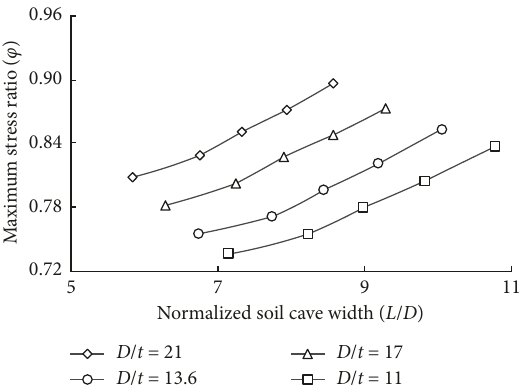
Figure 9: Influence of soil cave width on the maximum stress ratio.